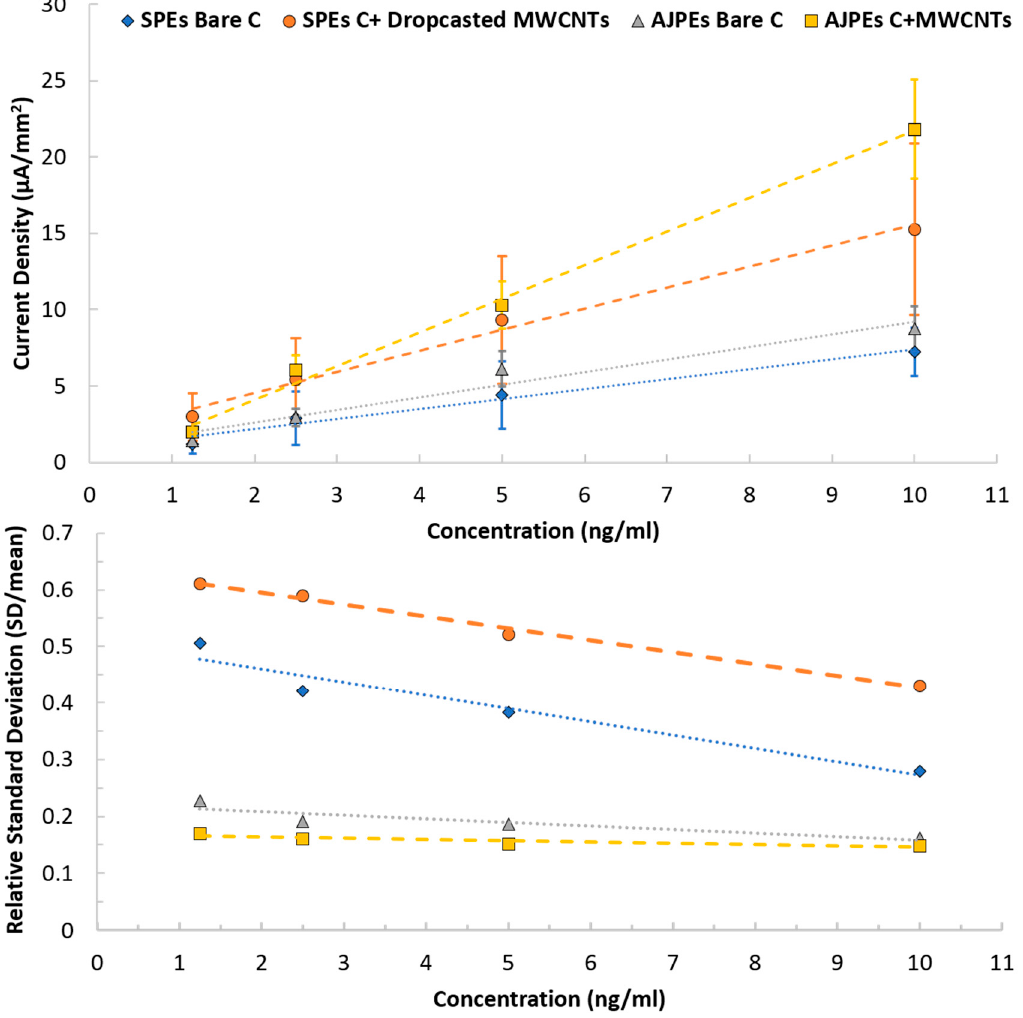
Figure 8. Calibration plot comparison between Carbon bare and nanostructured sensors.